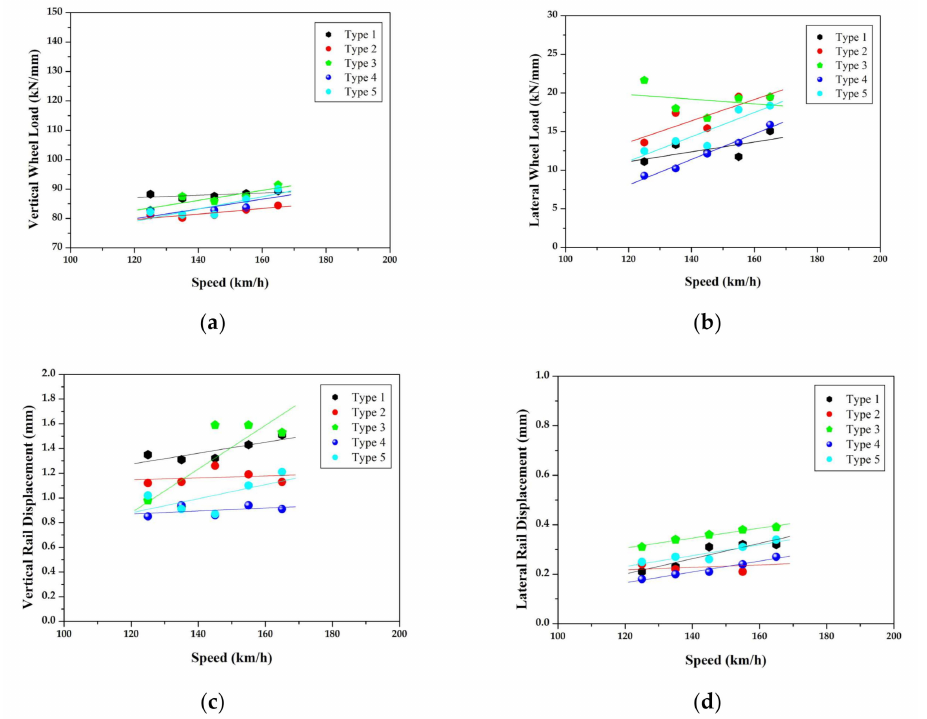
Figure 7. Trackside measurement result comparison for concrete track types: ( a ) wheel load, ( b ) lateral wheel load, ( c ) vertical rail displacement, and ( d ) lateral rail